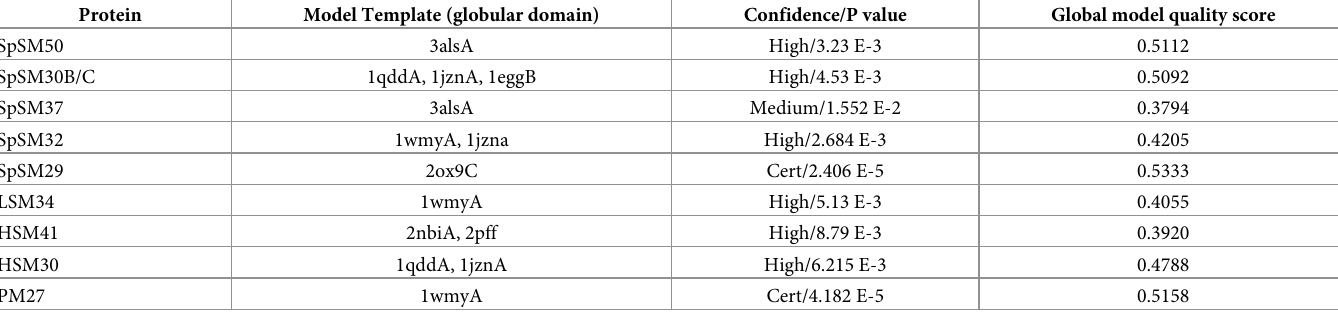
Table 2. DISOclust/INTFOLD4 fitted crystal structure template models homologous to conserved globular domains in sea urchin spicule matrix proteins. Protein Model Template (globular